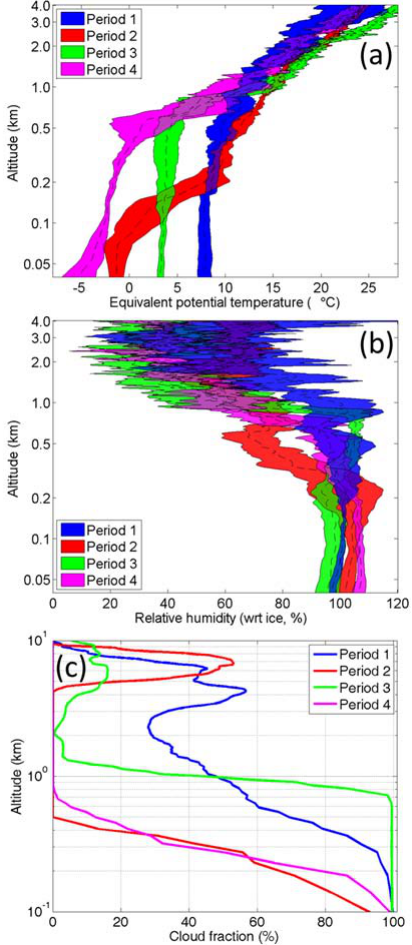
Fig. 5. Top two graphs show the median (thin dotted line) and the 25- to 75-percentile intervals (shading) for (a) the equivalent po- tential temperature and (b) relative humidity with respect to ice for the four periods discussed in this paper, (c) shows the median cloud fraction as a function of height. Note the logarithmic vertical axis and the higher top in the cloud fraction